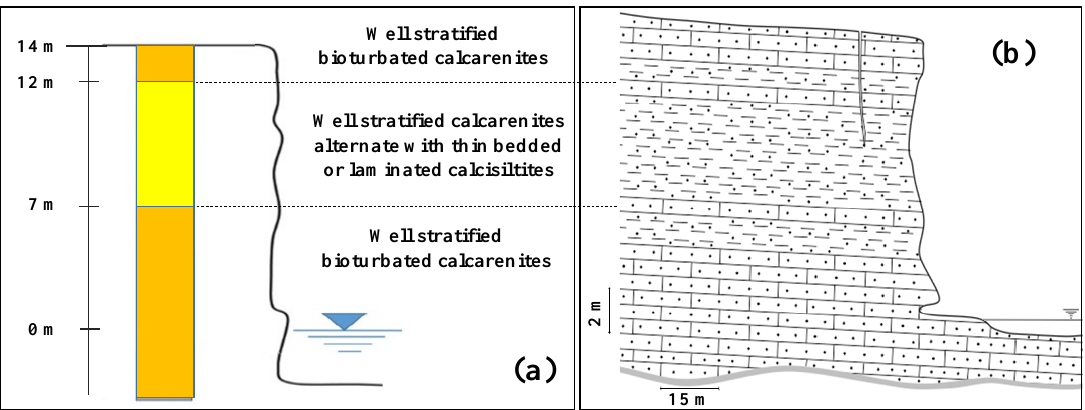
Figure 3. Stratigraphy of the site with alternating calcarenite layers: ( a ) Vertical survey a few meters to the cliff (from [16]); ( b ) observed stratification (from [13]).